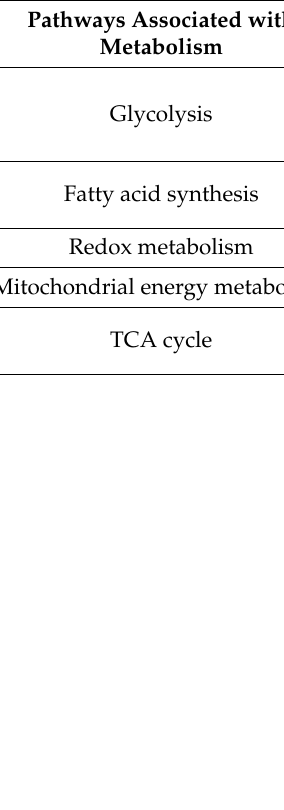
Table 2. A summary of the metabolic changes linked to drug resistance in